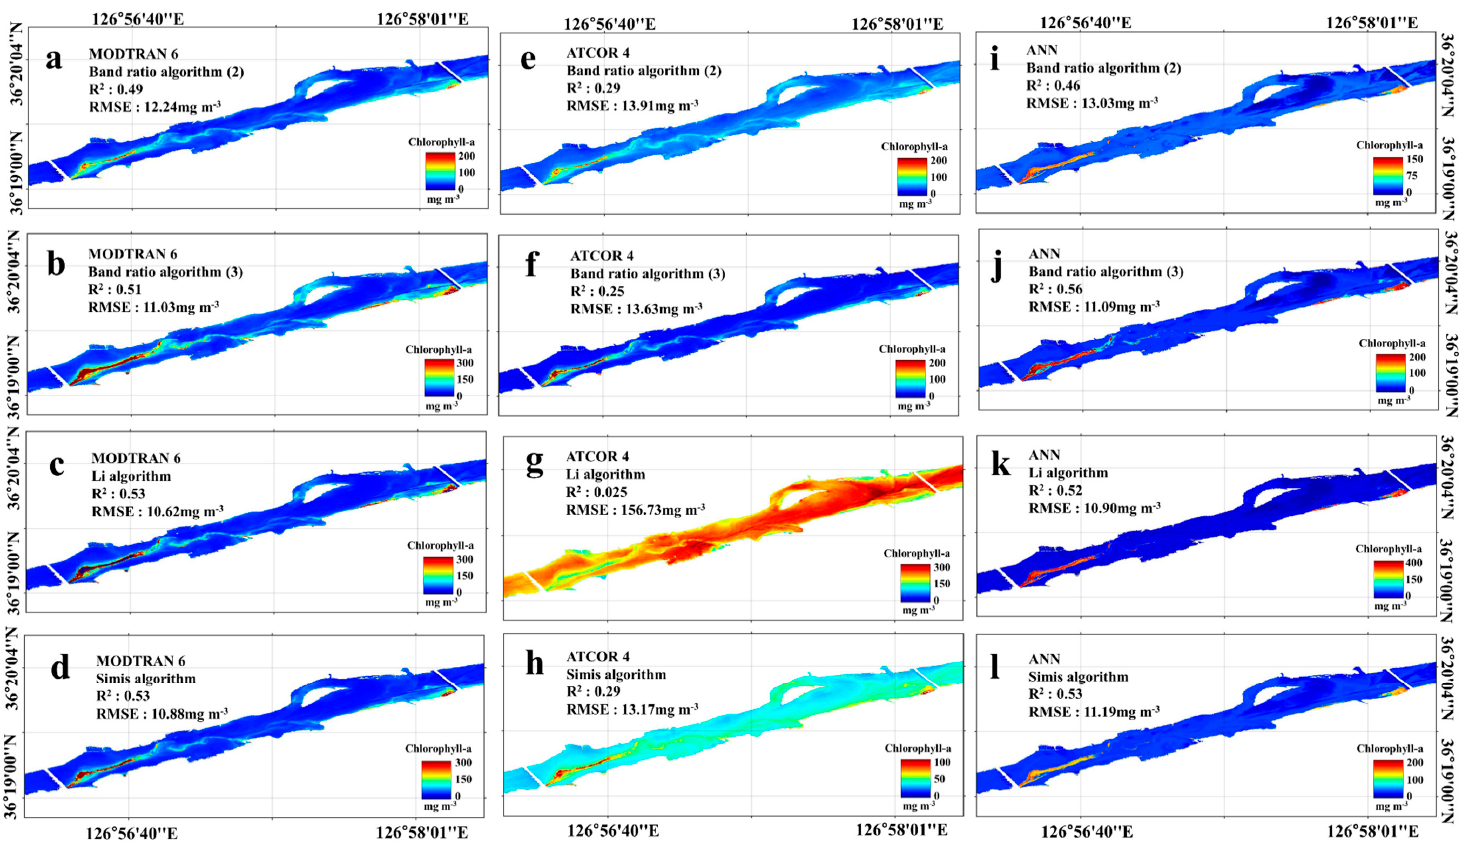
Figure 11. Chlorophyll - a (Chl-a) concentration images on 12 August 2016 in Section 1. Panels ( a – d ) show the Chl-a distribution driven by the MODTRAN 6 atmospheric correction. Panels ( e – h ) show the Chl-a distribution driven by the ATCOR 4 atmospheric correction. Panels ( i – l ) show the Chl-a distribution driven by the ANN atmospheric correction.